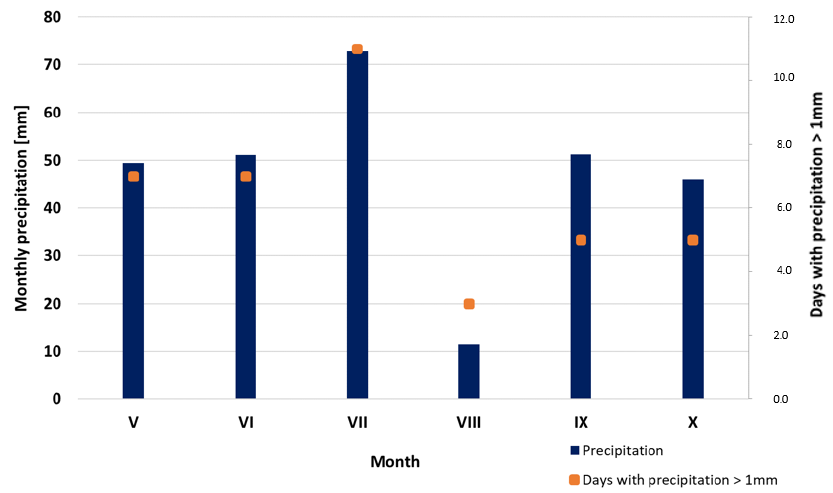
Figure 1. Histogram of total precipitation by month in the analysed period. Meteorological data were obtained from Faculty Agricultural and Hydrological Observatory Wrocław-Swojec (WOAiHW-S) .